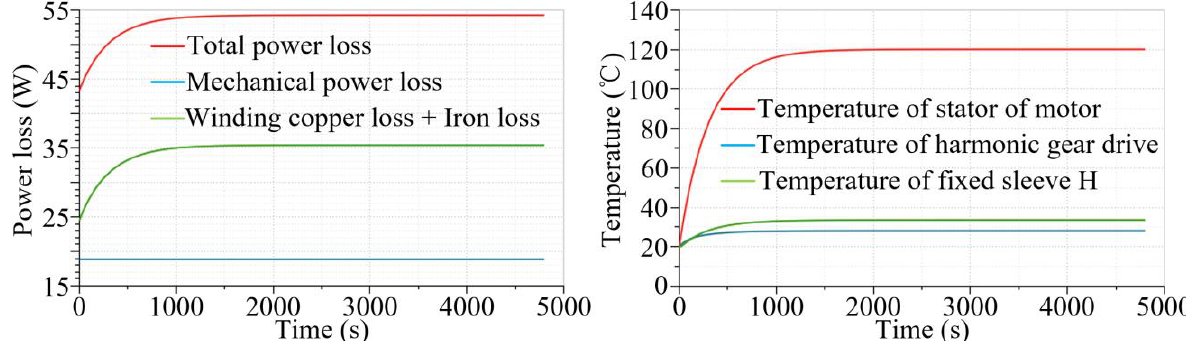
Figure 14. Variation of power loss and temperature over time (with the heat-conducting shell). The maximum diameter of the GIERM with a heat-conducting shell remained at